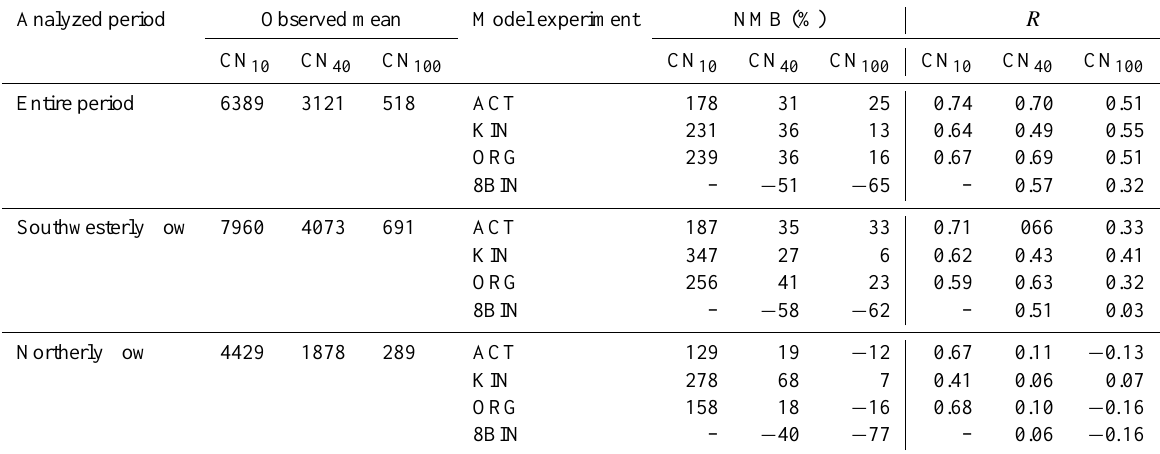
Table 2. Same as Table 1, except for the CARES T1 site. Analyzed